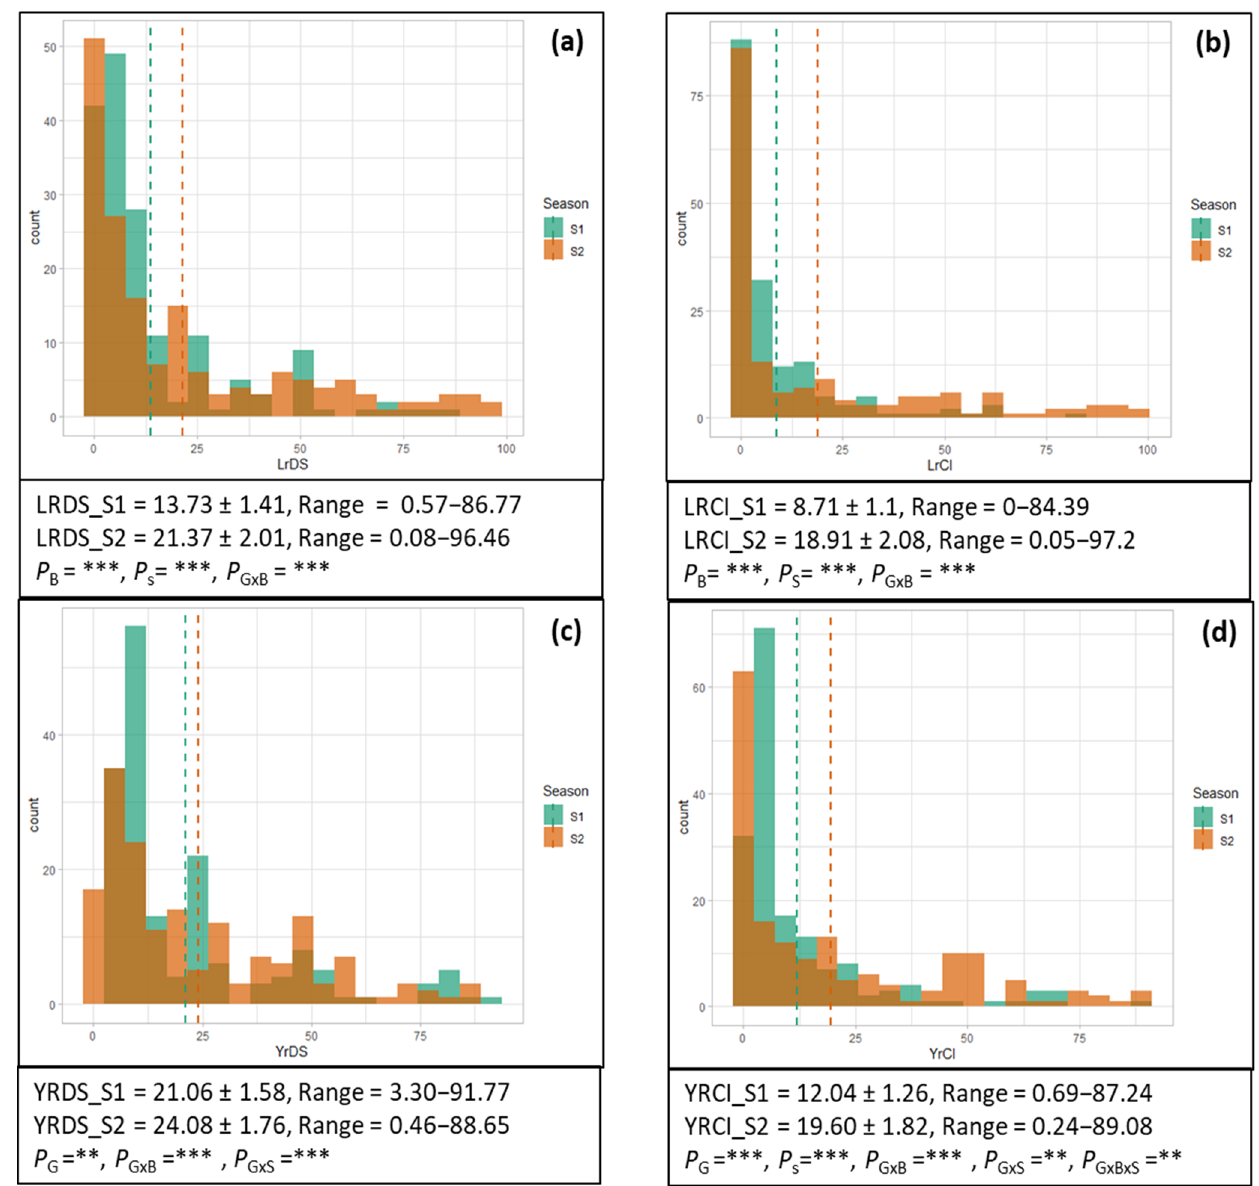
Figure 1. Overlaid histograms showing frequency distribution of ( a ) leaf rust disease severity (LRDS), ( b ) leaf rust co-efficient of infection (LRCI), ( c ) yellow rust disease severity (YRDS), and ( d ) yellow rust co-efficient of infection (YRCI) in season 1 (S1, green) and season 2 (S2, orange) where thin dashed colored lines indicate respective means. Tables below each histogram show mean ± S.E and range, whereas P indicates significant differences between genotypes (G), seasons (S), blocks (B), G × B interaction, G × S interaction, B × S interaction, and G × B × S interaction at, 0.01 (**) and 0.001 (***) significance level ( p